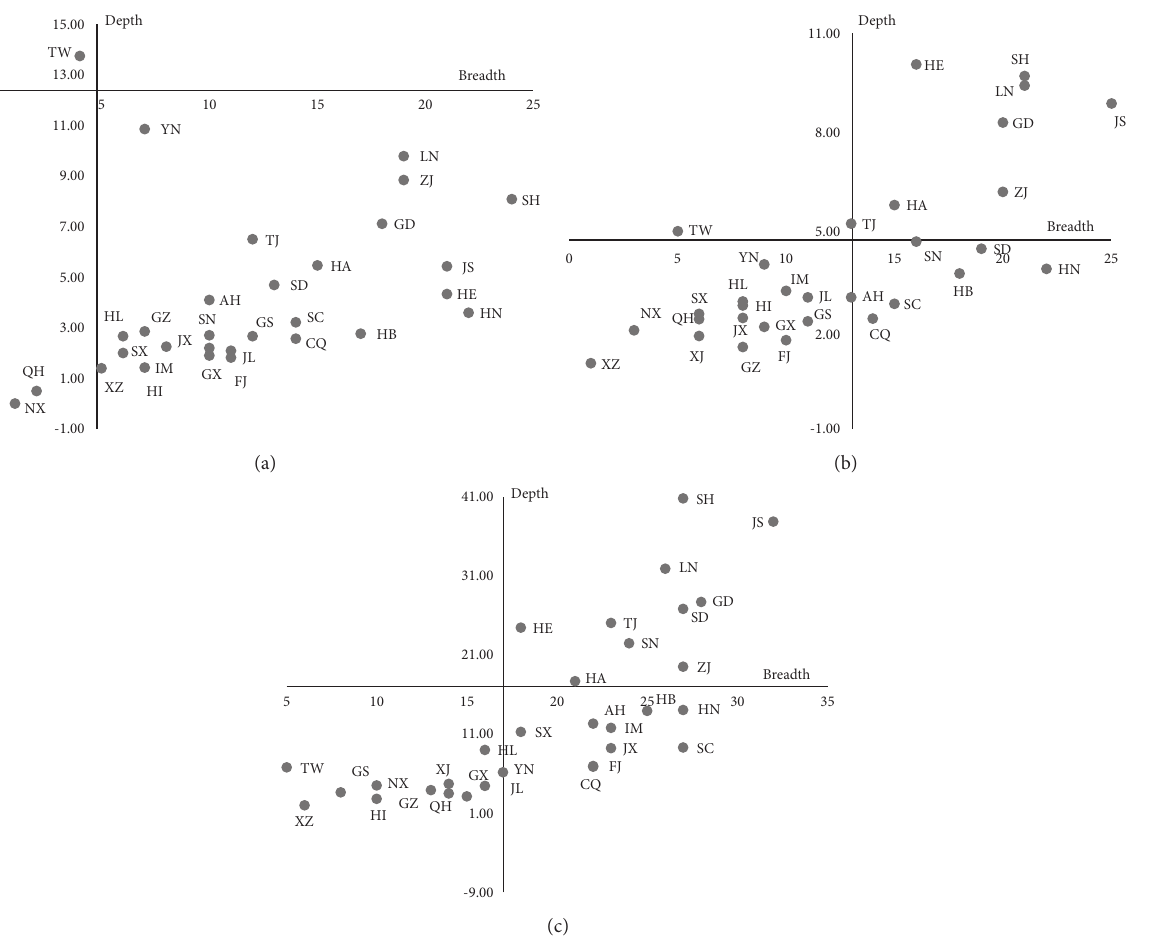
Figure 8: Breath and depth distributions of interprovincial innovation collaboration. (a) The first stage. (b) The second stage. (c) The third stage. Note: AH: Anhui; BJ: Beijing; FJ: Fujian; GS: Gansu; GD: Guangdong; GX: Guangxi; GZ: Guizhou; HI: Hainan; HE: Hebei; HA: Henan; HL: Heilongjiang; HB: Hubei; HN: Hunan; JL: Jilin; JS: Jiangsu; JX: Jiangxi; LN: Liaoning; IM: Inner Mongolia; NX: Ningxia; QH: Qinghai; SD- Shandong; SX: Shanxi; SN: Shaanxi; SH: Shanghai; SC: Sichuan; TW: Taiwan; TJ: Tianjin; XZ: Tibet; XJ: Xinjiang; YN: Yunnan; ZJ: Zhejiang; CQ: